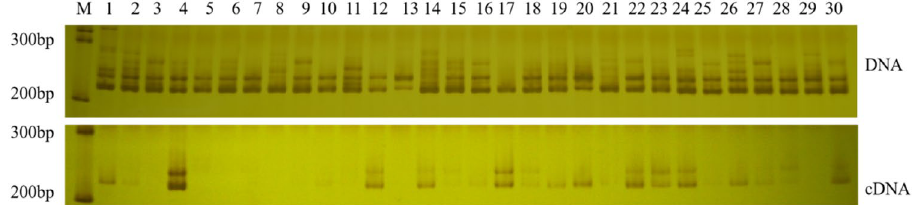
Figure 2. Electrophoretic map of the PSY-1a marker in some chrysanthemum accessions at the DNA and cDNA levels. Lanes 1 to 30 correspond to chrysanthemum accessions 1 to 30 in Supplementary Table 1; M: 100 bp DNA ladder marker. The images were cropped and the original images are presented in Supplementary Fig. 10.